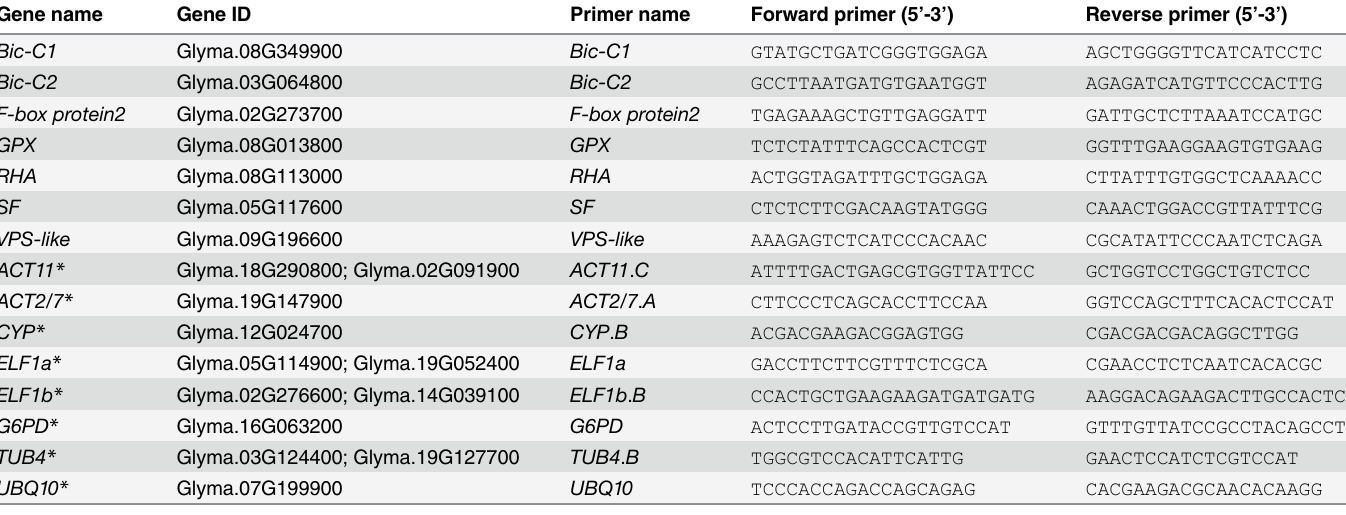
Table 1. RT-qPCR primer sets used in this study and their target genes.